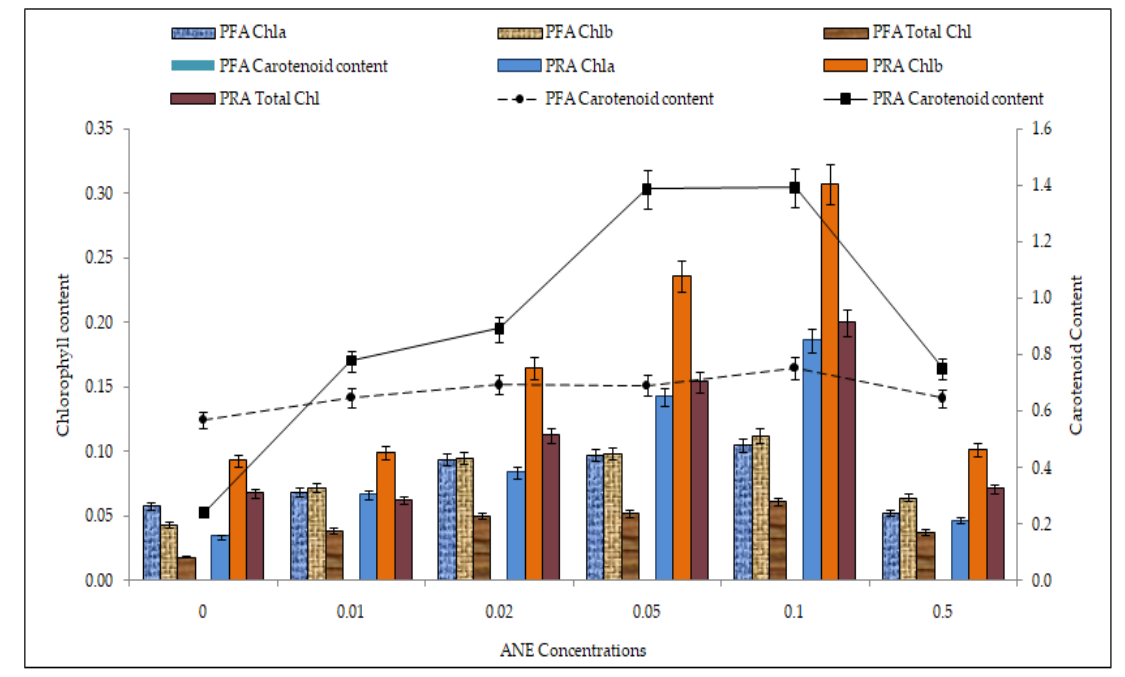
Figure 7. Efficacy of ANE on photosynthetic pigment accumulation. Bar indicates mean ± SD (n = 3). Table 9. ANOVA for pot foliar application (PFA) and pot root application (PRA) of ANE on the photosynthetic pigments. Total Chl: PRA Total Chl: PFA